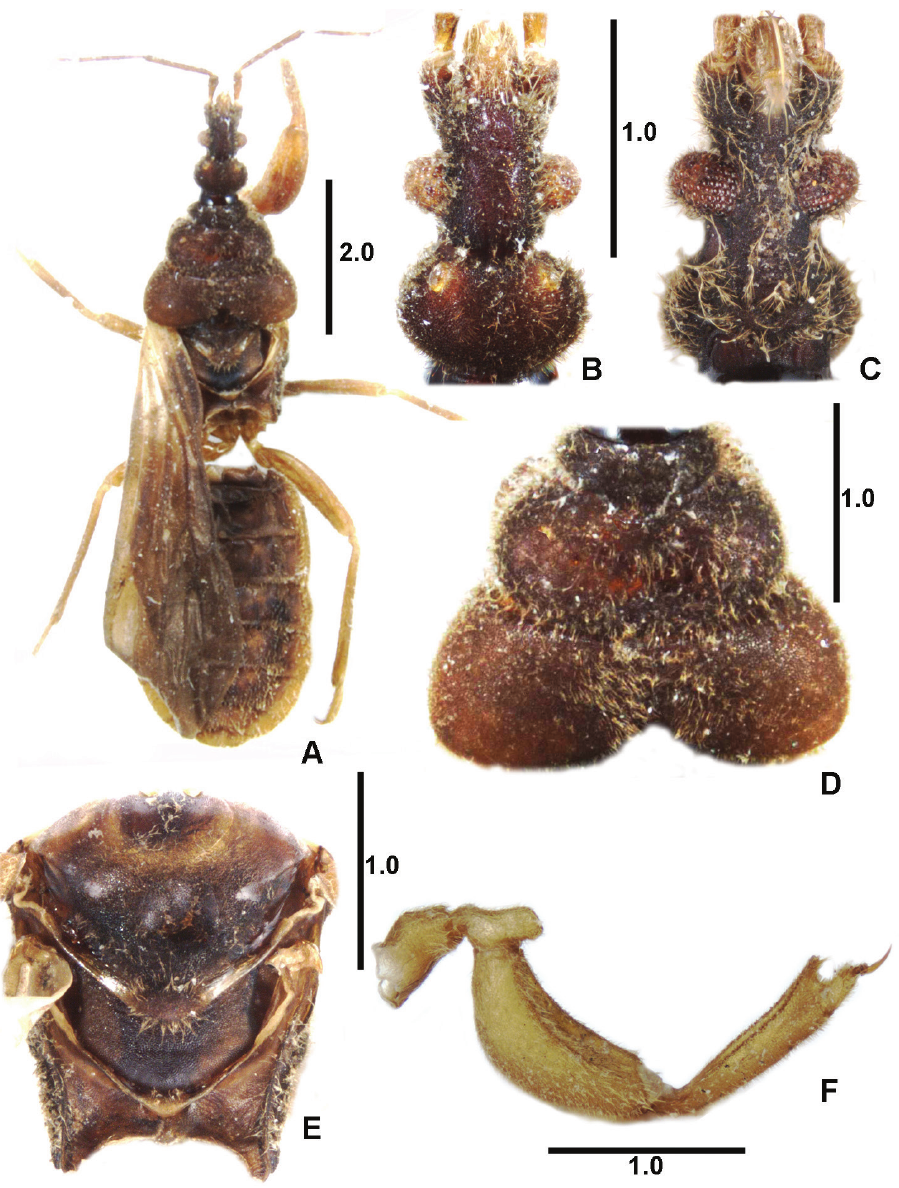
Figure 1. Xenicocephalus tomhenryi sp. n., female holotype A dorsal habitus B head, dorsal view C head, ven- tral view D pronotum, dorsal view E pterothorax, dorsal view F left foreleg, posterior view. Scale bars in mm. Forefemur (Figs 1F, 3C) strikingly thick and curved, arcuate, dorsal face convex, ventral face deeply and percurrently concave; groove delimited by two marginal rows of densely packed minute subglobular platelets, surface of concavity densely pilose. (Neopatella [cf. Štys and Baňař 2007] not